Question: How would you classify this visualization?
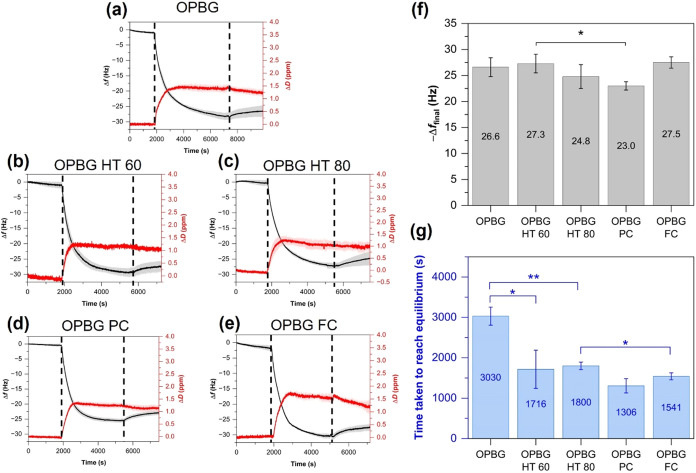
Answer: bar